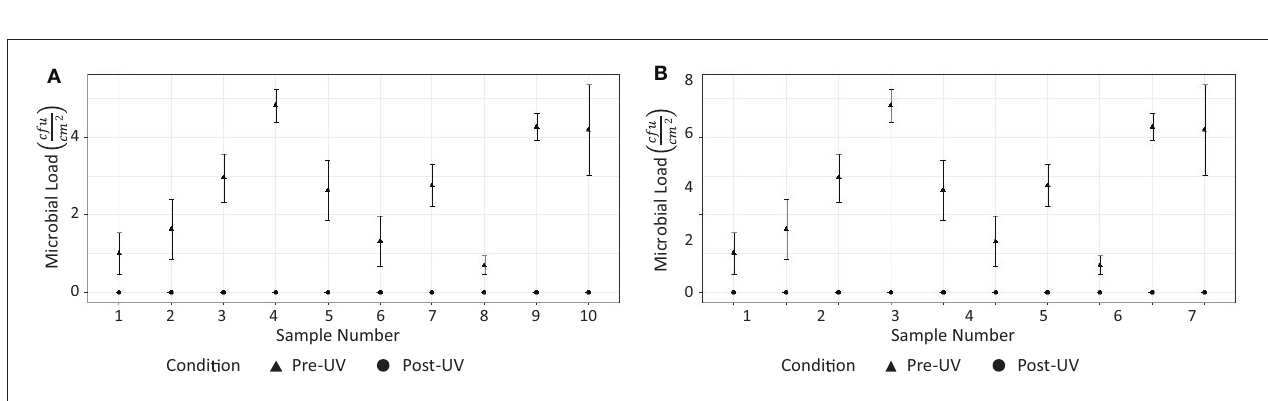
FIGURE 4 | Schematic illustrating the layout of the rooms, the location of the swab points in each room, and the approximate location of the robot during the defined irradiation periods: (A) CT scan room; (B) interventional suite. The swept area of the UV lamp is illustrated for location 1 to provide an indication of the volume of space covered. [Drawings not to exact scale].